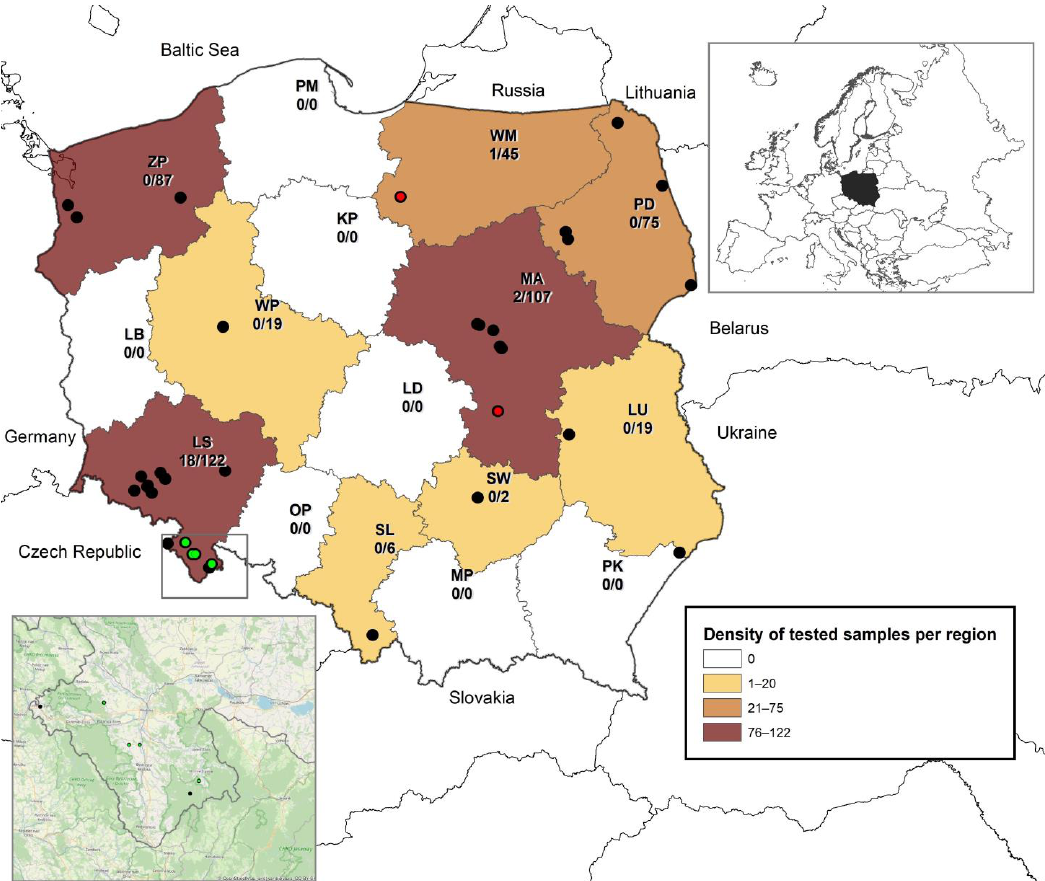
Figure 1. Map showing the voivodeships of Poland and the origin of bat samples included in the study with their RT-PCR results (black: negative; red: positive (alphaCoV); green: positive (SARS- related CoV)). The number of positive vs. total samples per region is indicated. AlphaCoVs were detected in bat feces collected in June 2020 at Warmian-Masurian (WM, accession